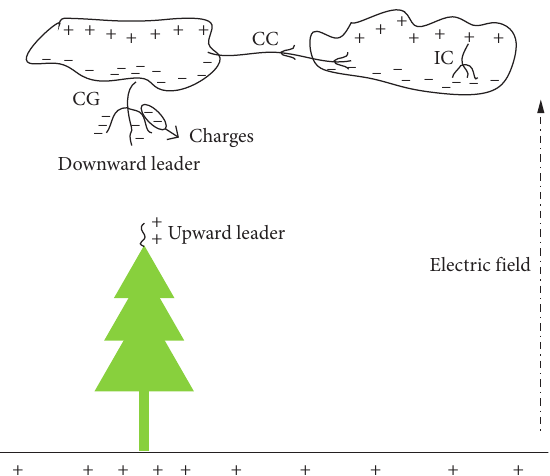
Figure 1: Development of downward and upward leaders initiating a